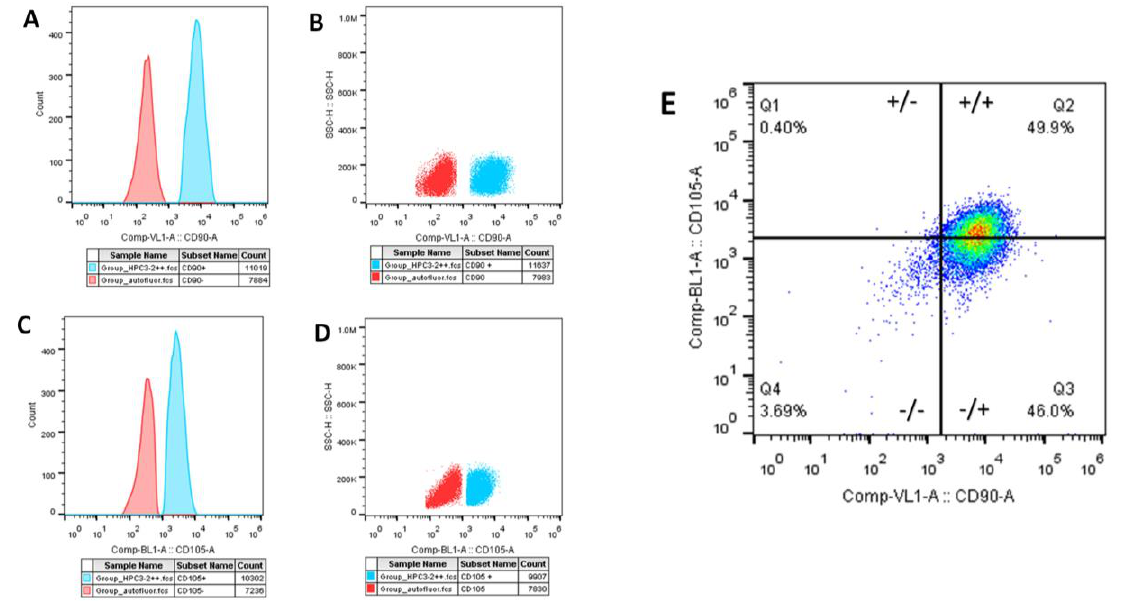
Figure 1. Flow cytometric characterization of hDPSCs. hDPSCs (90% confluence, 4 PDL) were cultivated for 48 h. ( A , B ). The population of cells labeled with the antibody anti-CD90 was 60% positive ( C , D ), and the population labeled with the anti-CD105 antibody was 59% positive. In orange, the population of negative cells (autofluorescence) and in blue, the positive cells. ( E ) Population of double-positive cells for CD105 and CD90, corresponding to 49.9% positive. Antibody used anti-human-CD90 superbright 436 and anti-human-CD105 Alexa Fluor. hDPSCs = human dental pulp stem cells; PDL = population doubling level.